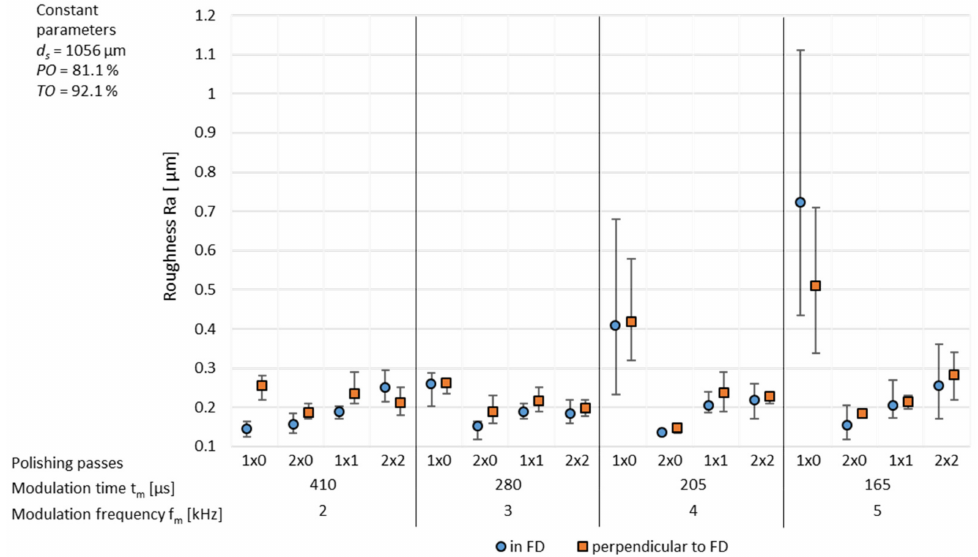
Figure 20. Achievable roughness Ra with multiple polishing passes depending on the modulation time t m and modulation frequency f m